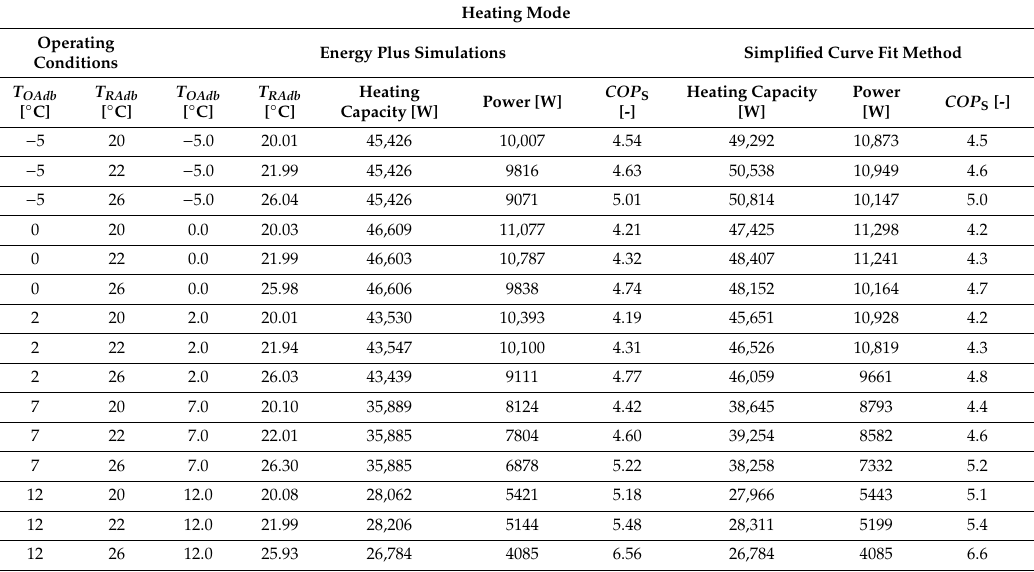
Table A4. Benchmark simulations for the air-to-air heat pump (heating